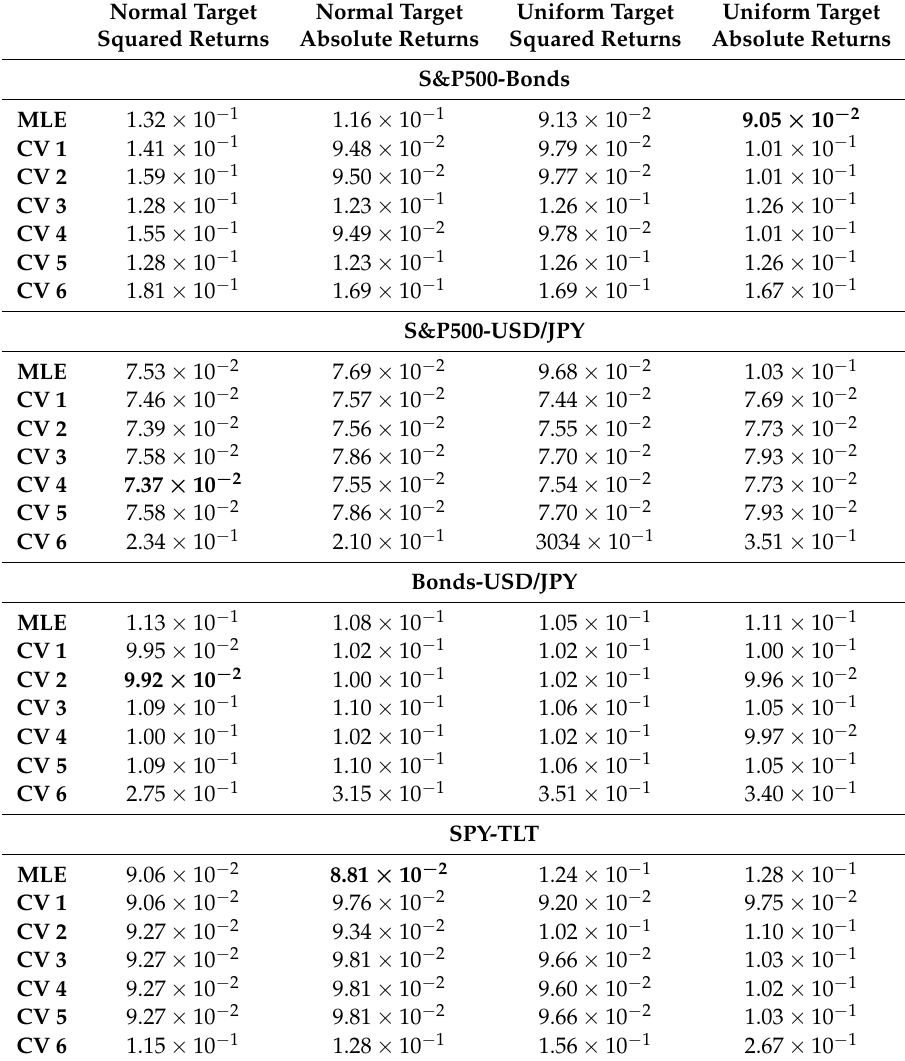
Table 7. Multivariate NoVaS model selection: MSE between ρ t | t − 1 and ˆ ρ t | t − 1 .